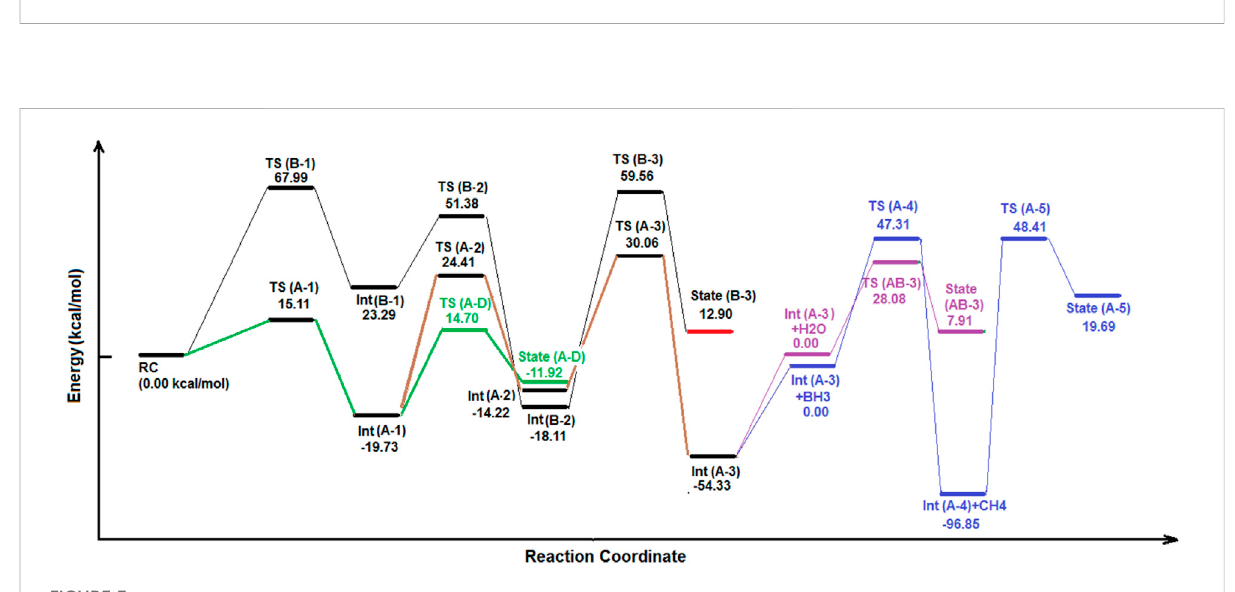
SCHEME 1 Total scheme of the reaction between CO 2 and borane 1, leading to production of formic acid 3, mono boric acid 2 , and metaboric acid trimer 4